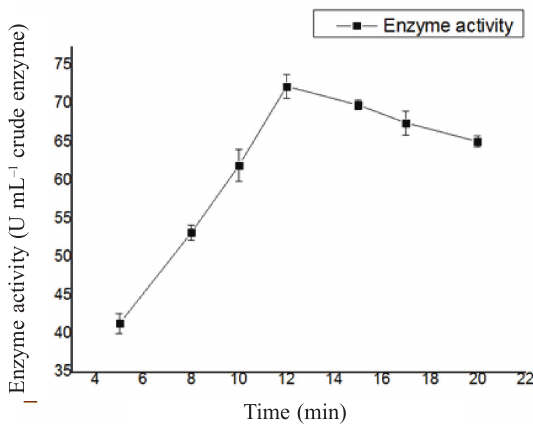
Fig. 5 – Effect of treating time on enzyme separation